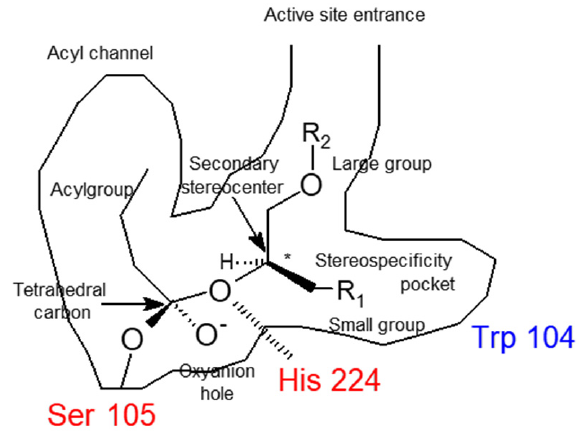
Figure 2. Suggested model for the faster-reacting enantiomer, the R -form, of the general substrate 1-O-alkyl-2-alkanol, in the active site of CALB